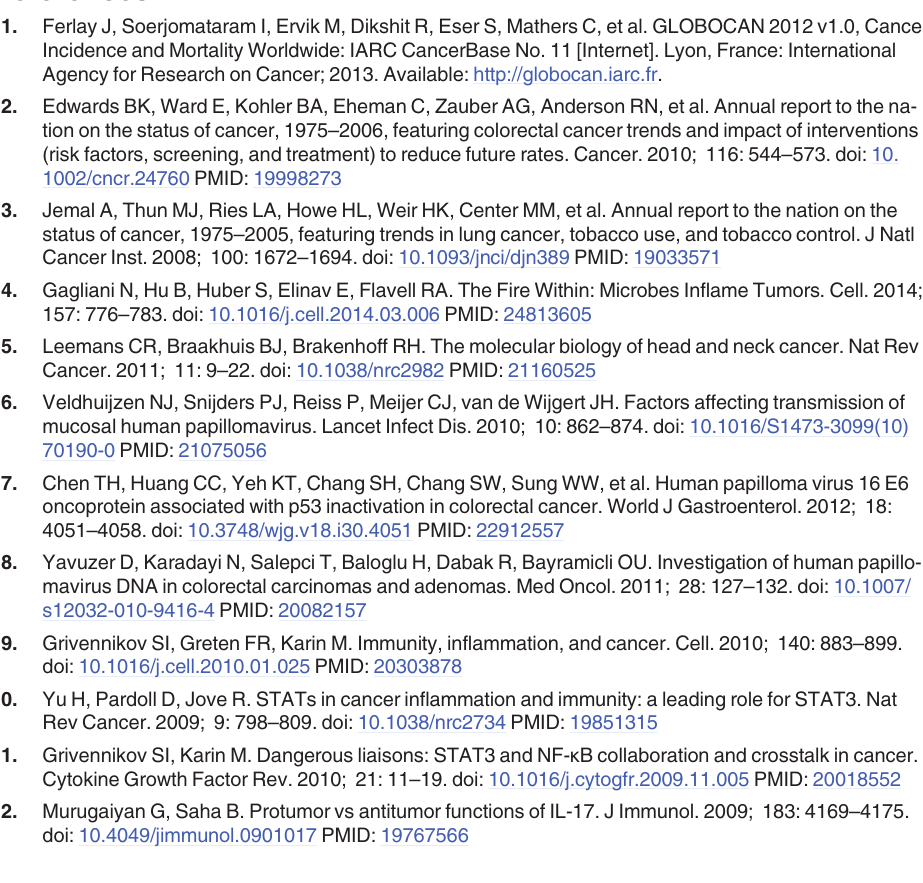
S1 Fig. GeneChip hybridization detects HPV DNA in colorectal tissues. Numbers shown in dotted-line boxes represent HPV subtypes (e.g., 16 and 18) and there are 23 HPV-specific probes shown. PC is a positive control (filled blue round dot) placed on every chip membrane. (A) Shows a CRC tissue which is positively hybridized for HPV16 subtype (blue round dot in the square 16). (B) Shows a CRC tissue which is negative for all HPV probe